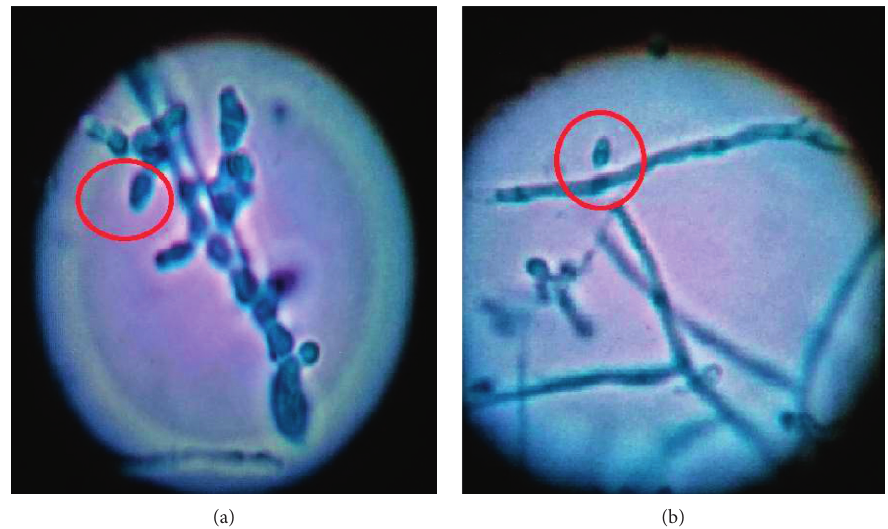
Figure 3: Lactophenol cotton blue mounted examination under 100X shows moderate numbers of slender clavate to pyriform microconidia suggestive of T. rubrum .